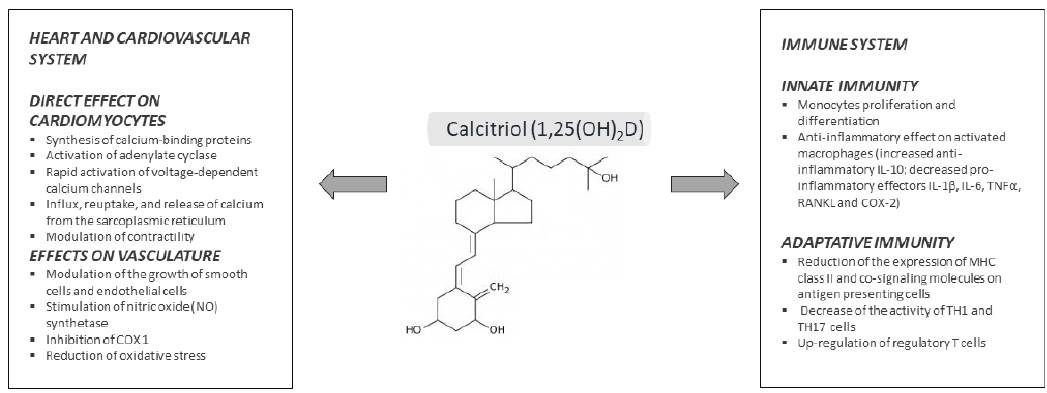
Figure 3. Pleiotropic effects of calcitriol on immune system and cardiovascular system.